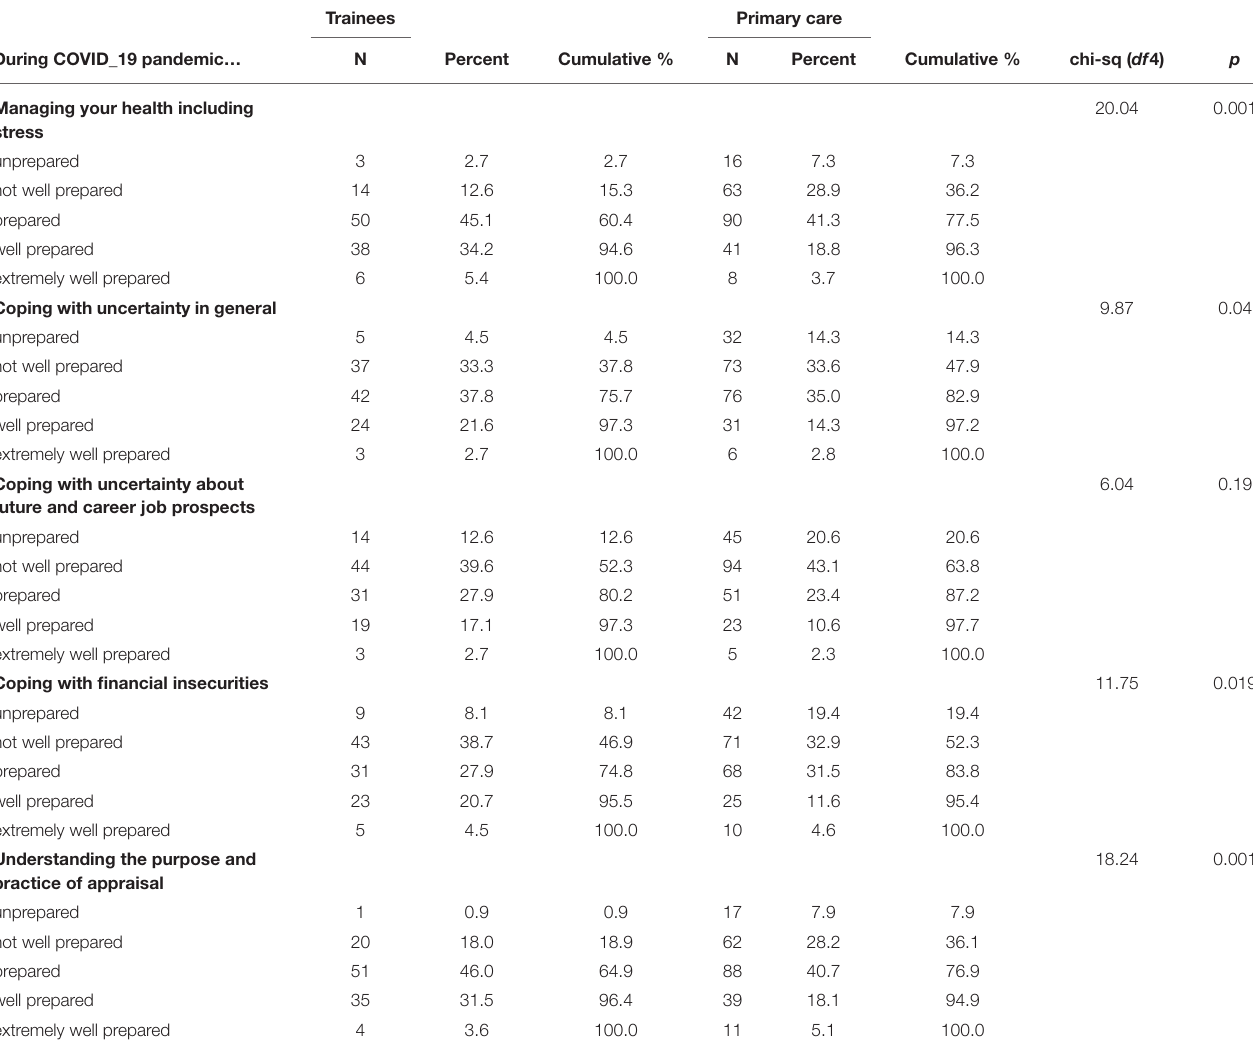
TABLE 3 | Frequency breakdown of preparedness of P-Cope-C19 items across trainee and primary care staff groups. Trainees Primary care During COVID_19 pandemic… N Percent Cumulative % N Percent Cumulative % chi-sq ( df 4) p